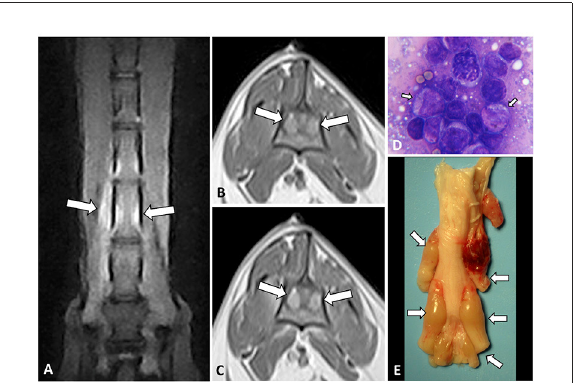
FIGURE3 Dorsal STIR (A) and transverse T1W pre- (B) and T1W post-contrast (C) images of the lumbar vertebral column of an 11-year-old Turkish Van cat with progressive non-ambulatory paraparesis. There is bilateral diffuse nerve root enlargement (arrows), which shows hyperintense on STIR (A) , mildly hyperintense on T1W (B) and heterogeneously enhancing (C) . A surgical biopsy smear (D) showed an abnormal population of pleomorphic lymphoid cells, with immature large lymphocytes with more abundant cytoplasm and pale chromatin (arrows), Romanowsky, 100x. Intraoperative euthanasia was elected, on the macroscopic sample (E) the nerve roots from L5 to sacral spinal cord segments were enlarged and swollen (arrows). TP was determined in 10 cases and was elevated in